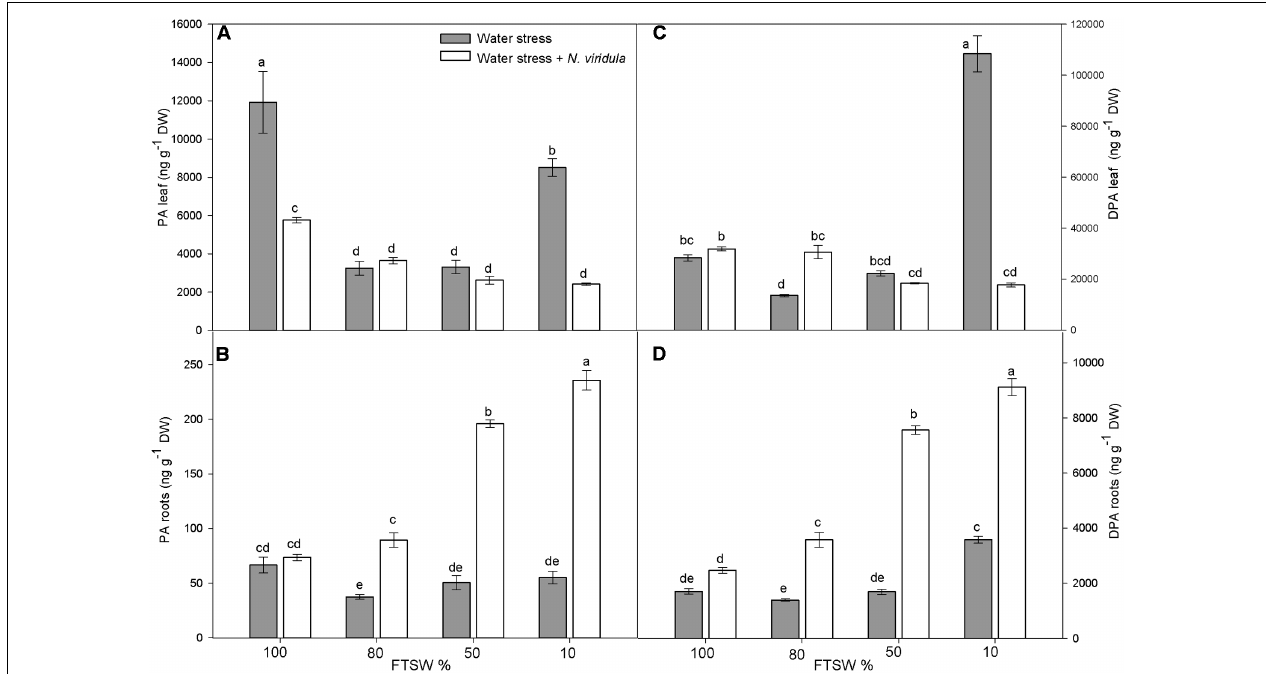
FIGURE 3 | Quantitative measurements (ng g − 1 DW) of ABA catabolites PA and DPA in well-watered and water-stressed broad bean plants with or without N. viridula infestation. Phaseic acid (PA; A,B ) and dihydrophaseic acid (DPA; C,D ) in leaves (A,C) and roots (B,D) of V. faba plants under developing water stress (gray bars) and with an associated presence of N. viridula infestation (white bars). Measurements were made at 100, 80, 50, and 10% of FTSW. Data are means ± SE ( n = 8). Different letters indicate significant differences ( P <